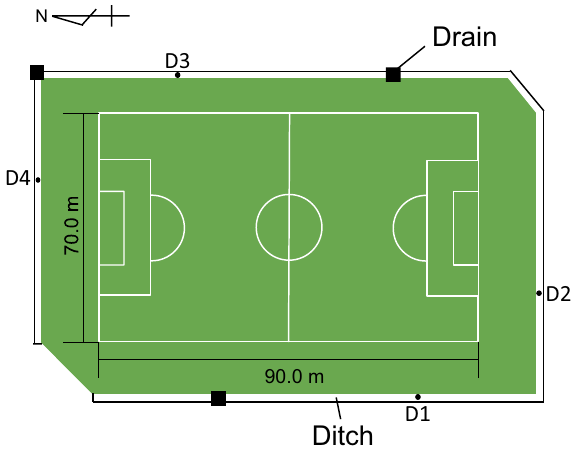
Figure 1. A schematic illustration of a ground plan of the artificial turf sports field of International Christian University. There are ditches along four sides of the field. Three small solid squares on the ditch indicate the drain that is connected to sewer pipes. D1-D4 indicate the locations where sediment samples were collected.